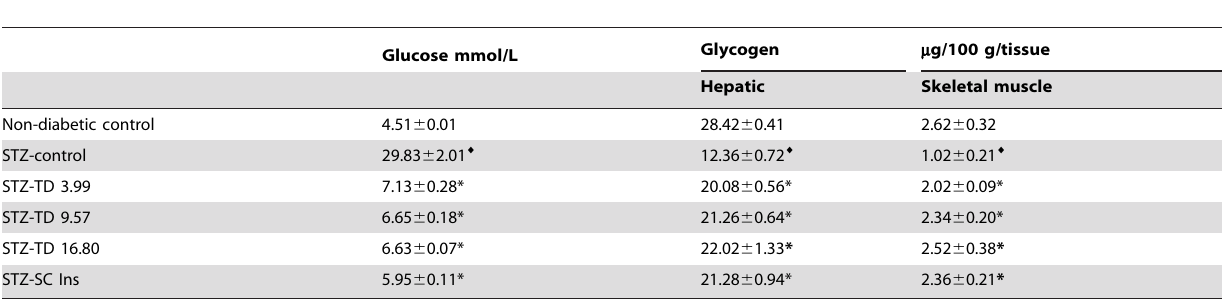
Table 3. Comparison of hepatic and muscle glycogen concentrations of STZ-induced diabetic rats treated with amidated PI hydrogel patches applied onto the skin with control animals.